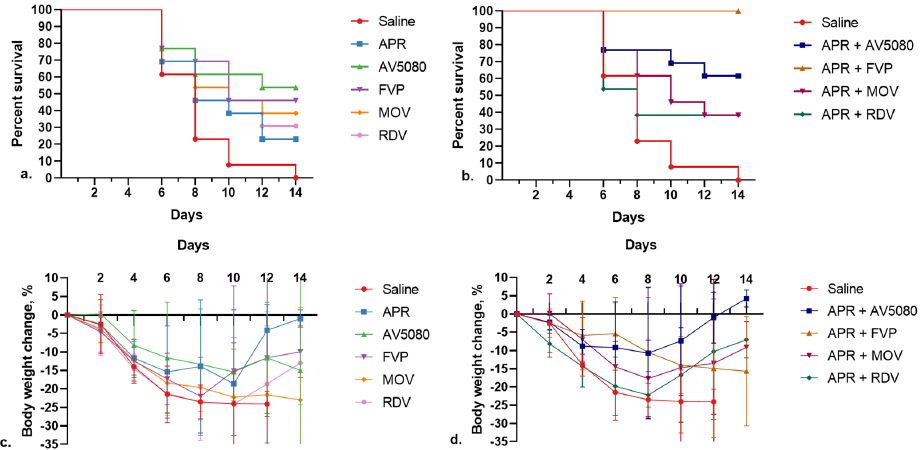
Figure 2. Survival ( a , b ) and change in the body weight ( c , d ) of mice treated with the drugs when infected with influenza virus A/California/04/2009 (H1N1). Table 1. Efficacy of drugs in the mouse influenza pneumonia model for infection with mouse-adapted influenza A/CA/04/2009 (H1N1)